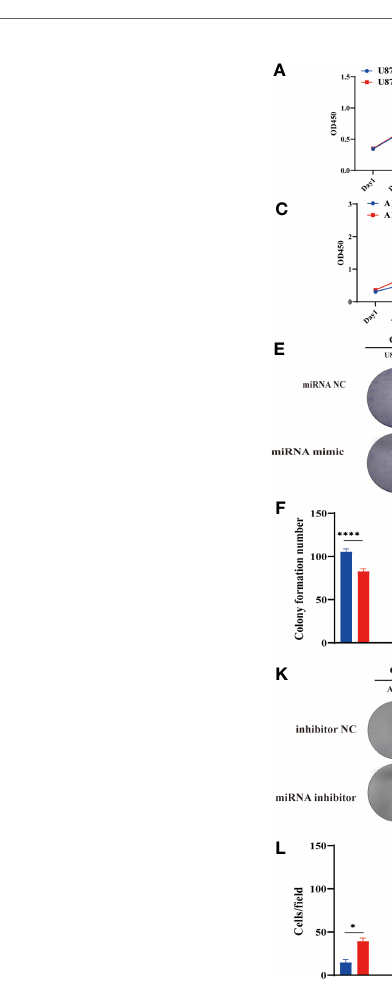
FIGURE 4 | MiR-877-5p suppress cell proliferation, colony formation, invasion, and migration. (A – D) CCK-8 assays were performed using U87-MG (A) and U251-MG (B) with or without hsa-miR877-5p mimic and using A172 (C) and T98G(D) cells with or without hsa-miR877-5p inhibitor. (E – J) Colony formation analyses (E, F) , transwell analyses (G, H) and matrigel-transwell analyses (I, J) of U87-MG and U251-MG with or without hsa-miR877-5p mimic were performed. Representative staining images are presented (magni fi cation: 200×; scale bar = 100 m m). (K – P) Colony formation analyses (K, L) , transwell analyses (M, N) and matrigel-transwell analyses (O, P) of A172 and T98G with or without hsa-miR877-5p inhibitor were performed. Representative staining images are presented (magni fi cation: 200×; scale bar = 100 m m). Data are presented as the mean ± SEM of 3 independent experiments. Signi fi cant results are presented as *P < 0.05, **P < 0.01, ***P < 0.001, and ****P <